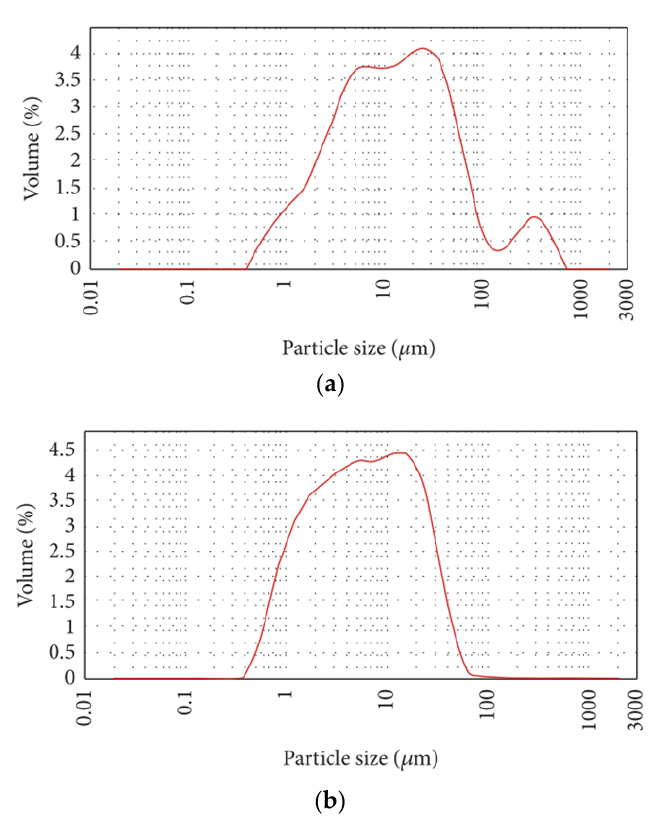
Figure 3. Particle size distribution (done by laser granulometry) of ( a ) LGP12, and ( b ) LGP5.